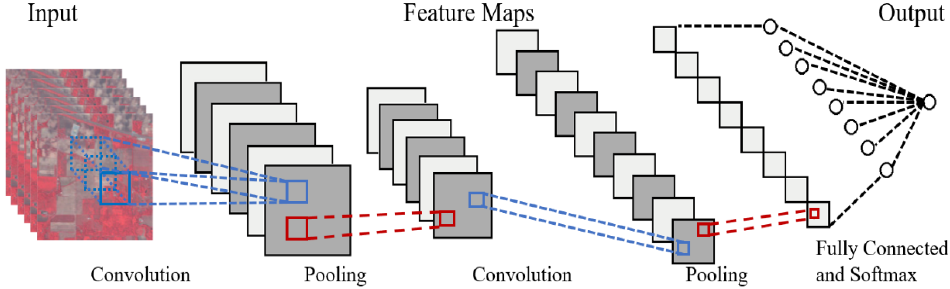
Figure 1. Typical convolutional neural network architecture, including convolutional, pooling, and fully connected layers and a softmax layer.